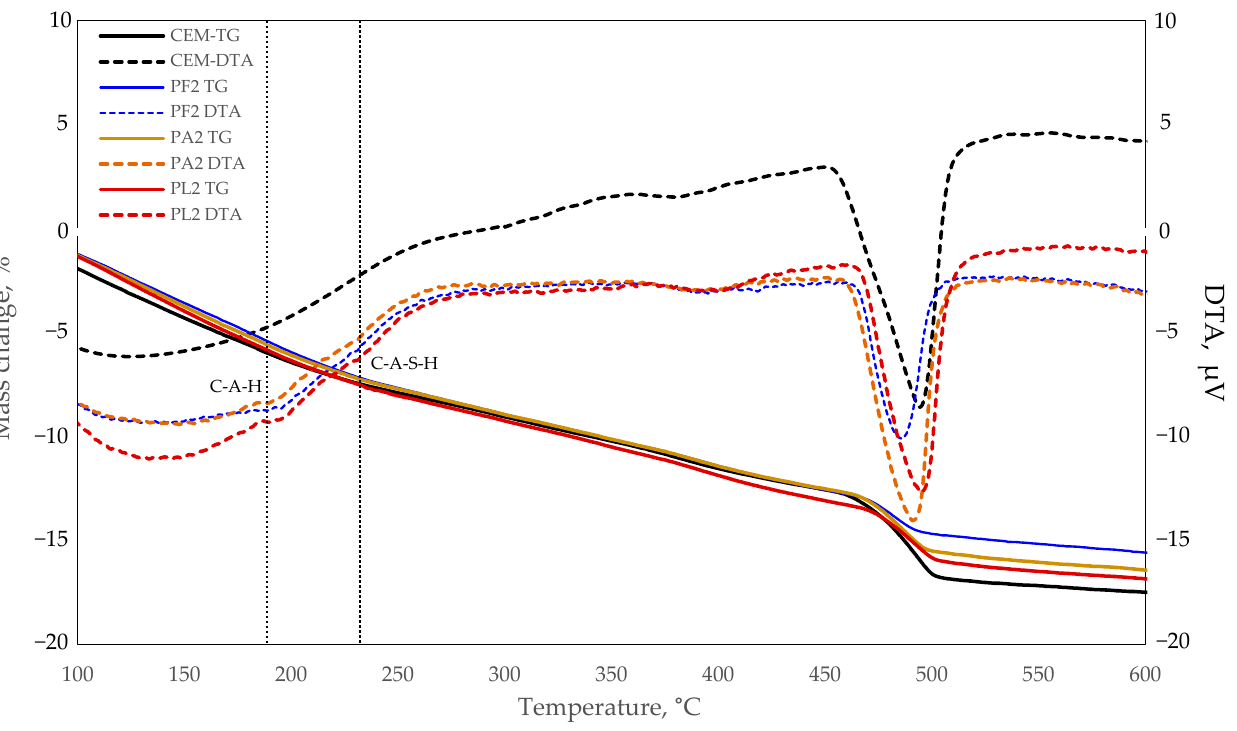
Figure 11. Graphs of thermogravimetric tests on hardened cement paste.